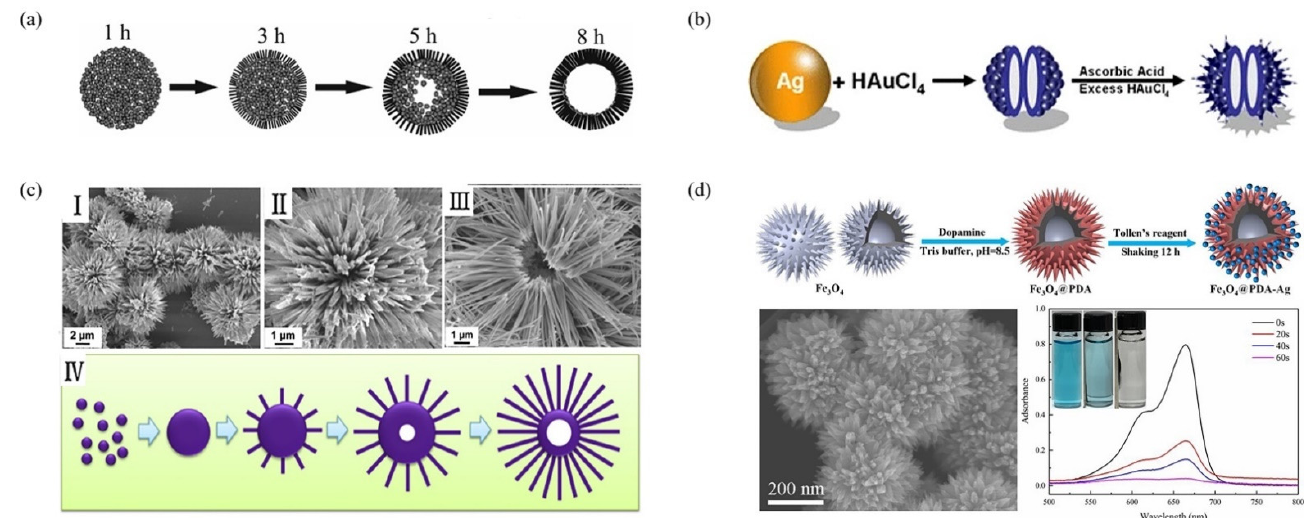
Figure 7. Examples of one-step preparation of urchin-shaped hollow micro-/nanoparticles: ( a ) Sche- matic Illustration of the Formation of R-MnO 2 Hollow Urchins via the Ostwald Ripening